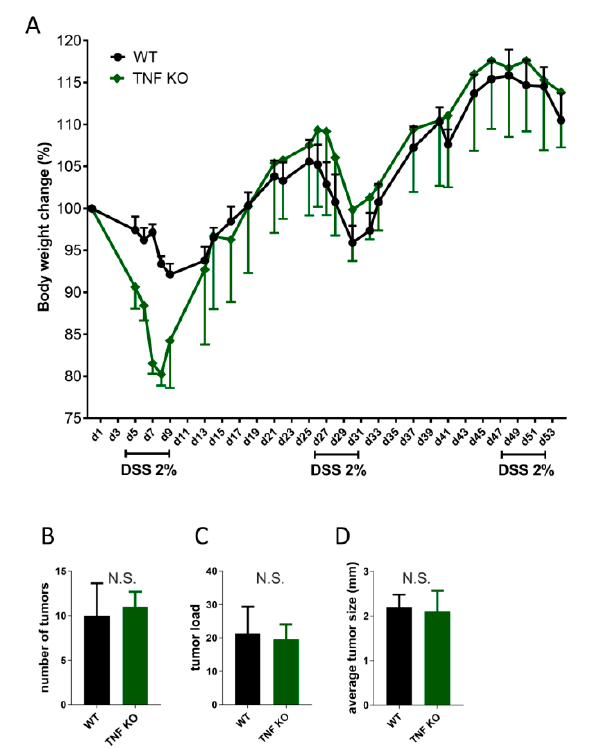
Figure 5. Genetic TNF ablation does not affect tumor incidence in the model of azoxymethane (AOM)/dextran sodium sulfate (DSS)-induced colorectal cancer following long-term co-housing with littermate control mice. TNF-deficient and heterozygous TNF +/ − littermate control mice received a single intraperitoneal (i.p.) injection of AOM (Sigma-Aldrich, Darmstadt, Germany) at a dose of 12 mg/kg body weight. A week after AOM injection, mice were given three cycles of 2% DSS in drinking water (Thermo Fisher) for five consecutive days followed by a two-week interval on drinking water without DSS. Body weight was measured throughout the experiment. After the last water cycle, mice were sacrificed and examined for polyp formation and colon length. ( A ).